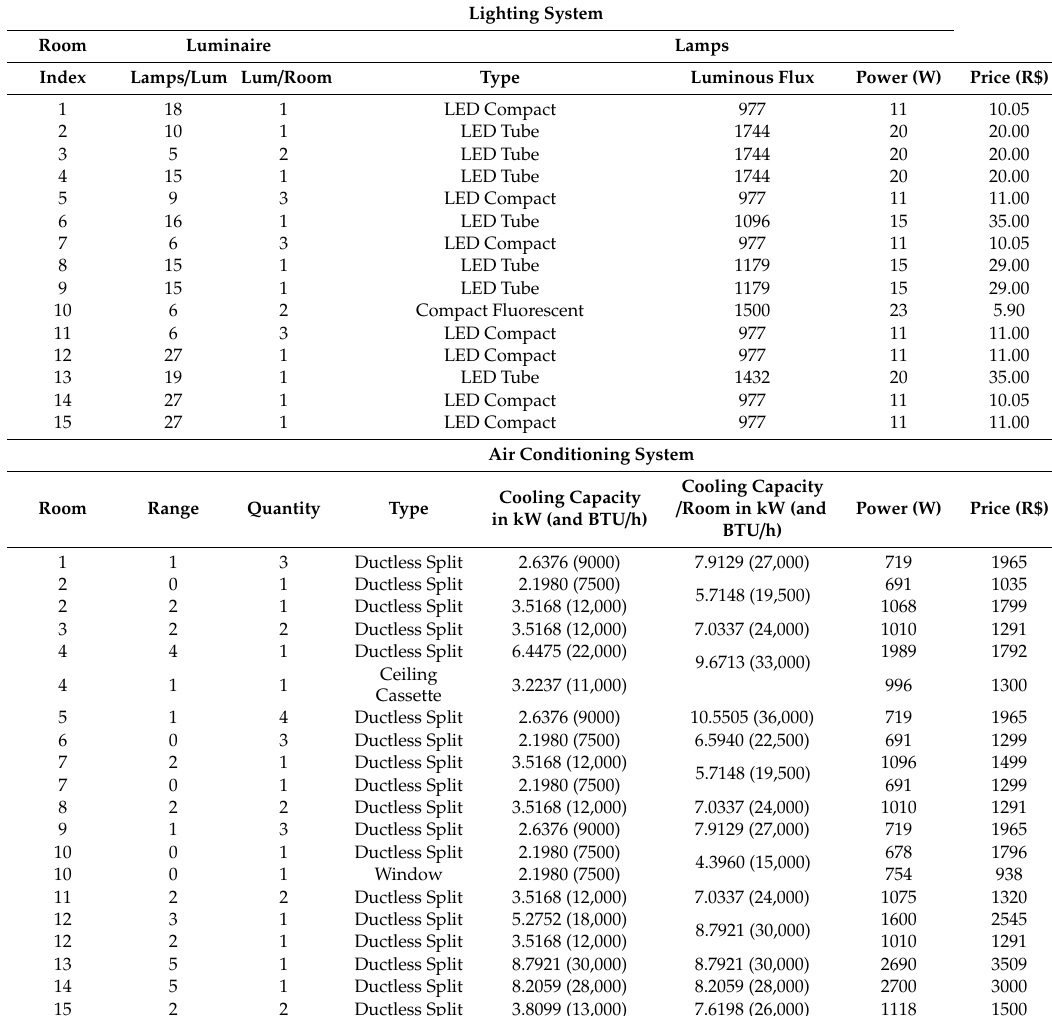
Table 7. Devices selected by the